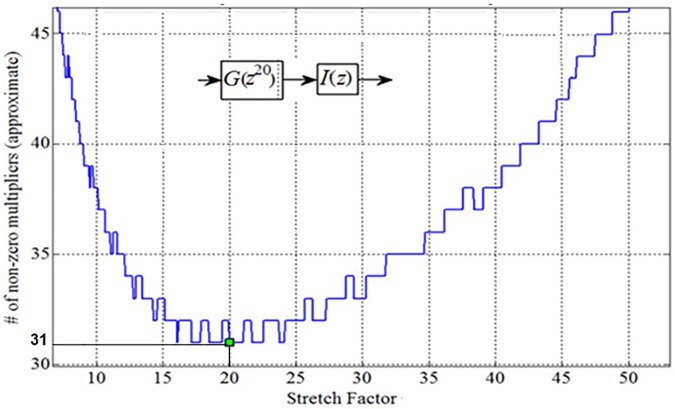
Optimum Stretch Factor for IFIR implementation of UPartial(z).